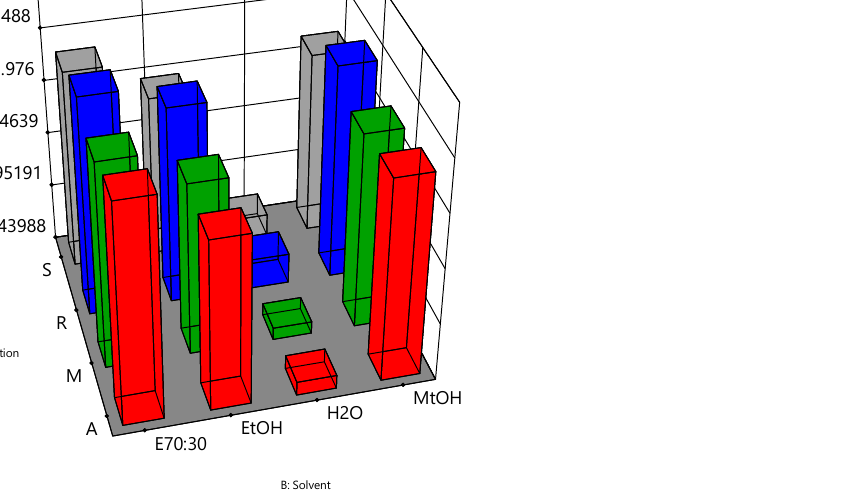
Figure 4. Interactive effects of extraction solvent and extraction method on the TPC assay for bee pollen samples. TPC values were expressed as mg gallic acid equivalent per gram pollen, B: extraction solvent (70% ethanol:30% = E70:30, ethanol = EtOH, water = H 2 O, and methanol = MtOH) and C: extraction process (agitation = A, maceration = M, reflux = R, and sonication = S).